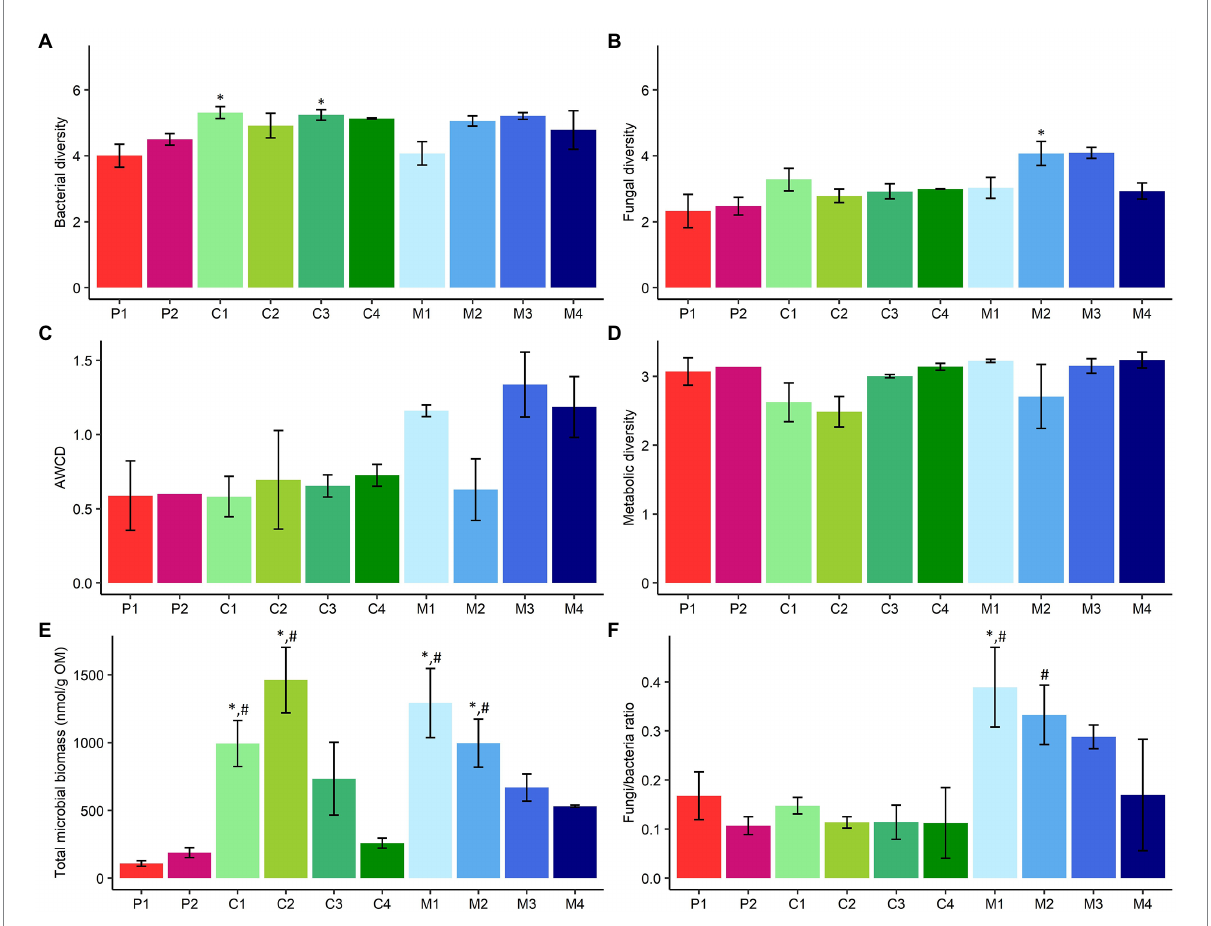
FIGURE 4 Comparison of microbiological characteristics of subtypes of peat-based substrates, composts, and management residues. (A) Mean bacterial diversity ± SE, calculated as the Shannon Diversity Index, based on 16S V3-V4 rRNA gene metabarcoding data. (B) Mean fungal diversity ± SE, calculated as the Shannon Diversity Index, based on ITS2 gene metabarcoding data. (C) Mean metabolic activity ± SE, expressed as AWCD (average well color development), based on data from community-level physiological profiling using Biolog EcoPlates. (D) Mean metabolic diversity ± SE, calculated as the Shannon diversity index, based on data from community-level physiological profiling using Biolog EcoPlates. (E) Mean total microbial biomass ± SE (nmol/g OM), based on PLFA analysis data. (F) Mean fungal to bacterial ratio (F/B) ± SE, based on PLFA analysis data. P1 = pure peat-based substrates ( n = 5); P2 = limed peat-based substrates ( n = 5); C1 = green composts ( n = 7); C2 = VFG composts ( n = 3); C3 = woody composts ( n = 4); C4 = peat composts ( n = 2); M1 = grass clippings ( n = 4); M2 = chopped heath ( n = 4); M3 = forest sods ( n =